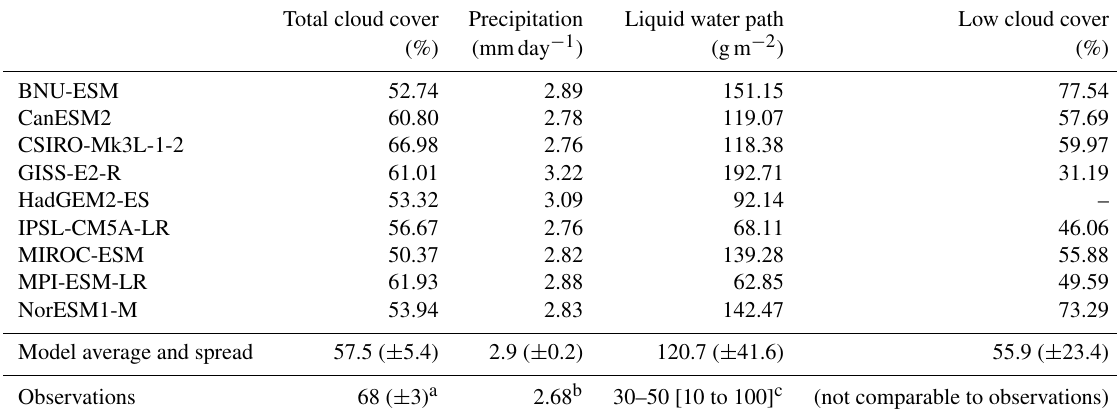
Table 2. Global averages for the 20 first years (2006–2025) of the RCP4.5 experiment. Model spread is given as one standard deviation. “Low cloud cover” is calculated using a random overlap assumption for all vertical levels below